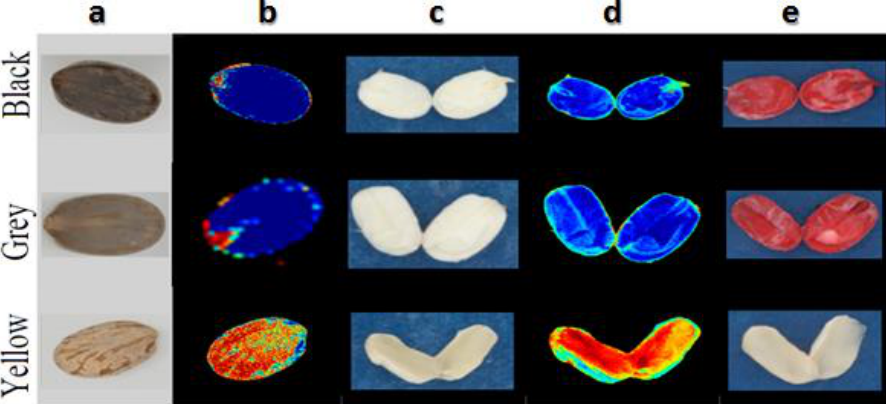
Figure 6. Classification of castor seeds into three classes based on visual colour of seed coat (yellow, grey and black). ( a ) RGB images of the intact seeds; ( b ) transformed images of intact seeds by nCDA; ( c ) RGB images of cut seeds; ( d ) transformed images of cut seeds by nCDA and ( e ) RGB images of cut seeds after immersion in tetrazolium solution (adapted from Olesen et al. [102]).